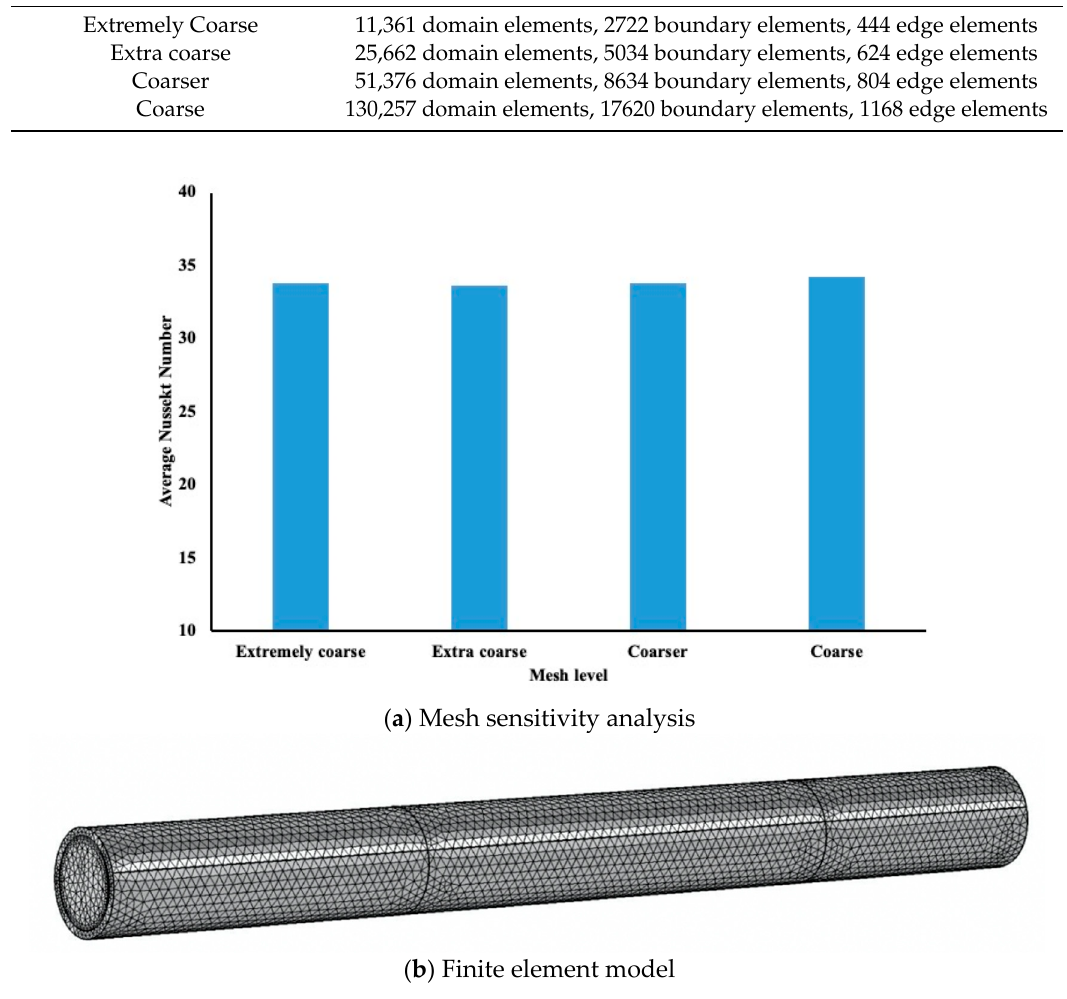
Figure 2. Finite element analysis. Table 2. Mesh information for different level of meshing.